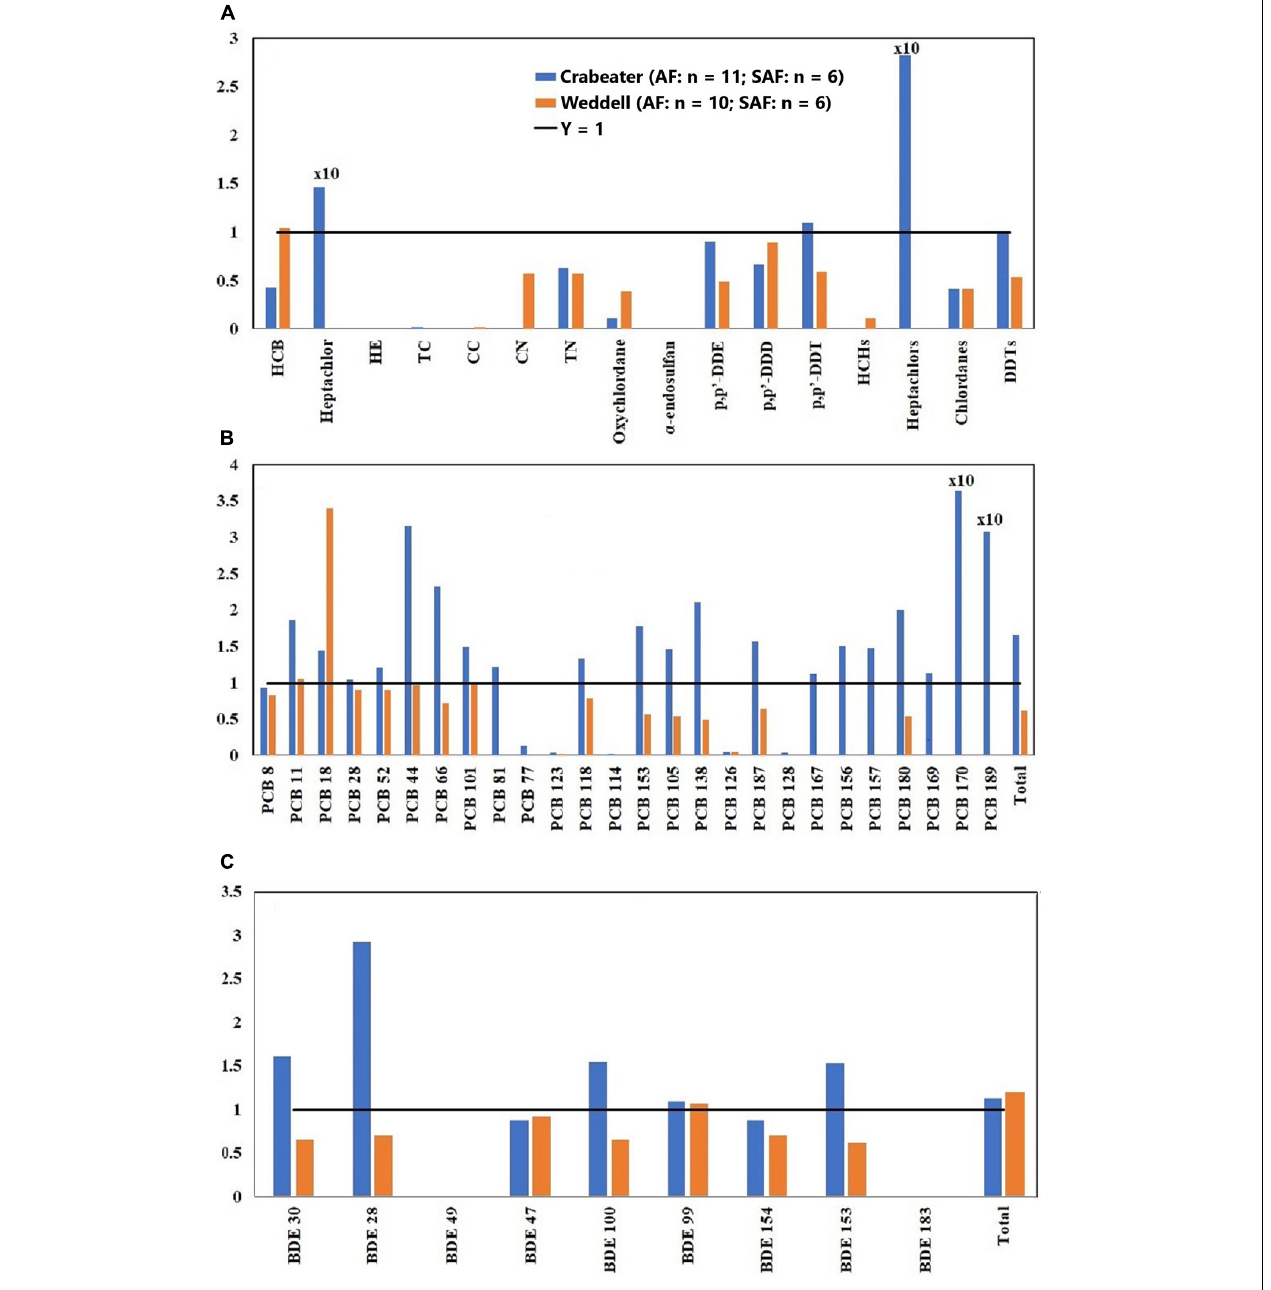
FIGURE 1 | Adult female (AF)/subadult female (SAF) concentration ratios of OCPs (A) , PCBs (B) and PBDEs (C) . HE, heptachlor-epoxide; TC, trans- chlordane; CC, cis- chlordane; CN, cis- nonachlor; TN: trans- nonachlor. See Table 1 for sample size in each group.